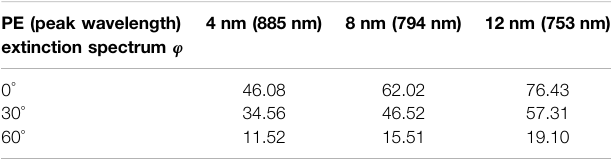
TABLE 2 | Data of extinction intensity at the longitudinal resonance peak under different PE